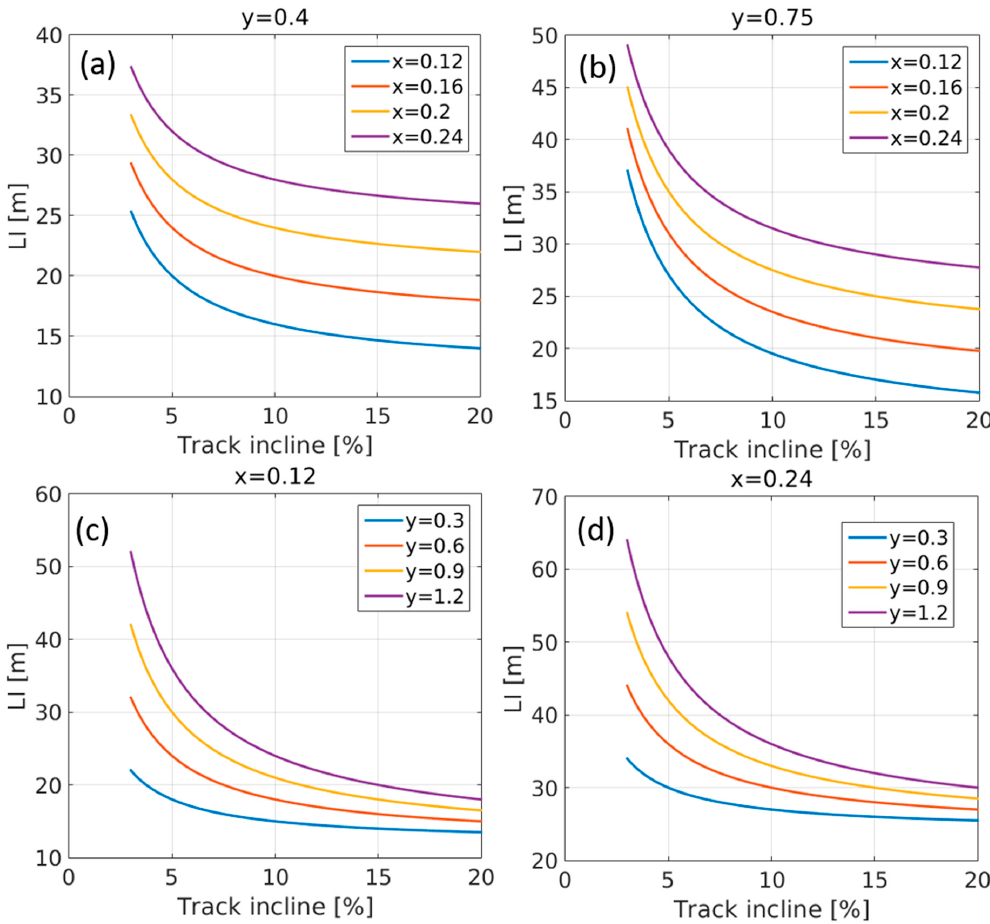
Figure 8. Modeling the length of longitudinal interval between successive spillways ( LI ) as a function of singletrack incline, according to geographical zone coefficient ( x : ranges between 0.12 (or less) for mesic conditions and 0.24 (or more) for xeric conditions), and soil erodibility coefficient ( y : ranges between 0.3 for most erodible soils and 1.2 for least erodible soils). LI for low-modestly erodible soils ( a ); LI for modestly-high erodible soils ( b ); LI for relatively mesic conditions ( c ); and LI for relatively xeric conditions ( d ).